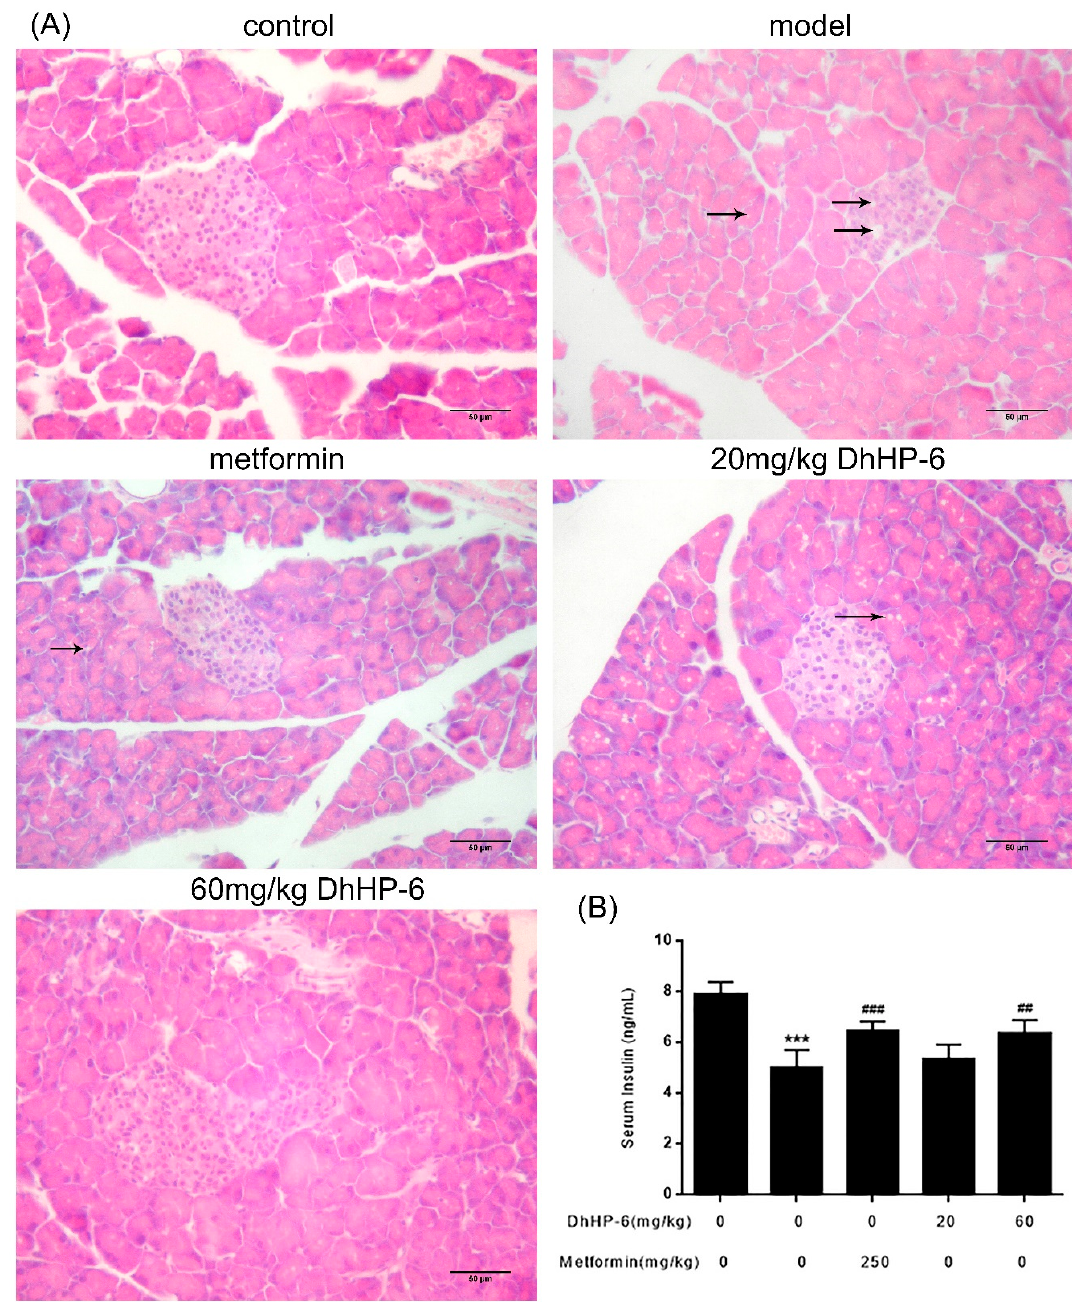
Figure 7. Effect of DhHP-6 on the structure and function of T2DM mice pancreas islets. ( A ) H&E was performed to evaluate the effect of DhHP-6 on the histology of T2DM mice pancreas islets. ( B ) Insulin in serum of T2DM mice was analyzed by ELISA. All results presented are means ± SD, n = 8. *** p < 0.001 vs. control group. ## p < 0.01, ### p < 0.001 vs. model group.